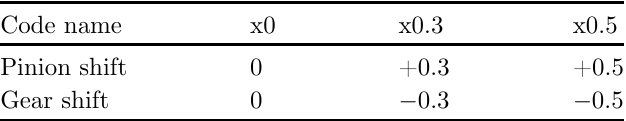
Table 2. Shift coef fi cient x of the simulated reference pro fi le normalised for m = 1 mm.